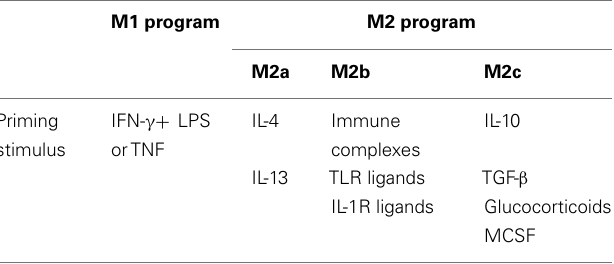
Table 1 | Priming stimulus for the classical (M1) and alternative (M2a-c) activation of